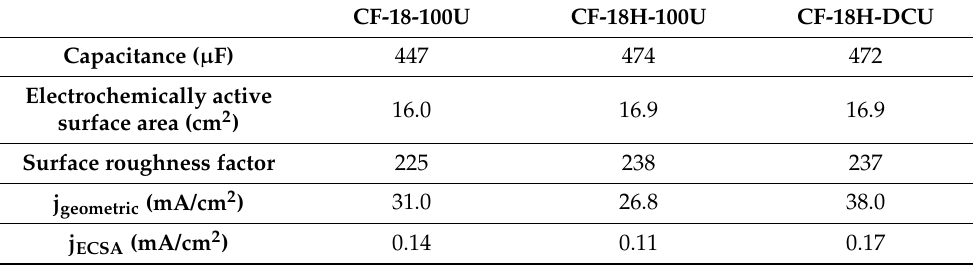
Table 1. Summary of capacitance and surface area of copper foams electrodeposited with and without urea. Applied potential of − 0.81 V vs. RHE for CF-18H, − 0.81 V vs. RHE for CF-18H-100U and − 0.79 V vs. RHE for CF-DCU. The geometric and ECSA normalized current densities of CO 2 electrolysis at the corresponding applied potentials are also listed as j geometric and j ECSA , respectively. CF-18-100U CF-18H-100U CF-18H-DCU Capacitance ( µ F) 447 474 472 Electrochemically active surface area (cm 2 )